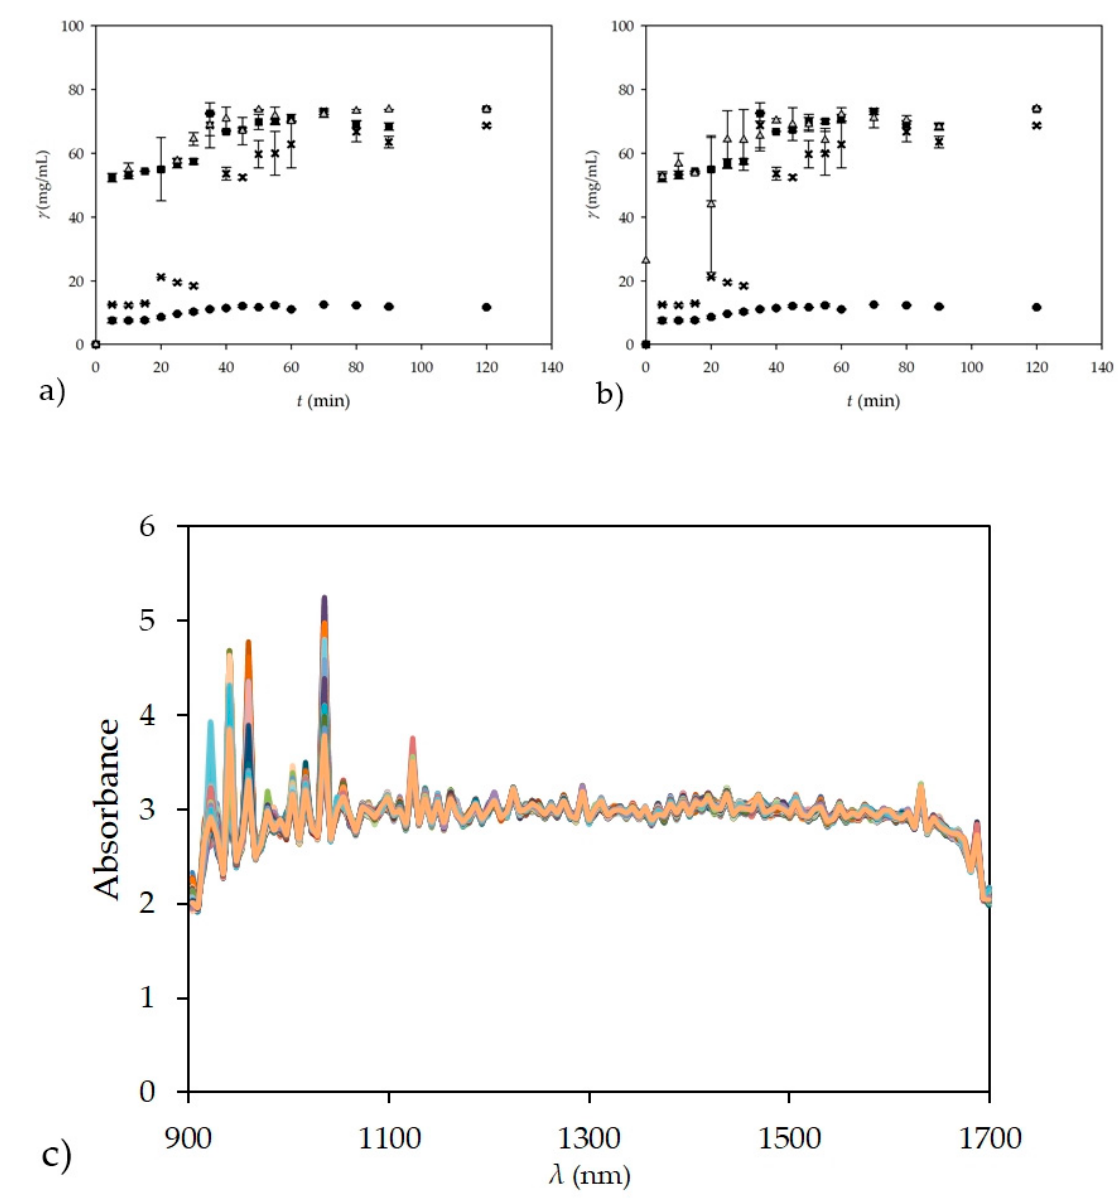
Figure 6. ( a ) Comparison of glycerol concentrations obtained by different methods during the biodiesel production process performed in a batch reactor; ( b ) comparison of glycerol concentrations obtained by different methods during the biodiesel production process performed in a batch reactor using subsampling ANN for NIR spectroscopy ( ■ — calculated, theoretical glycerol, x — gas chroma- tography, ● — UV-VIS spectrophotometry, ▲ — NIR spectroscopy); and ( c ) NIR spectra of the bio- diesel production process during a batch experiment.